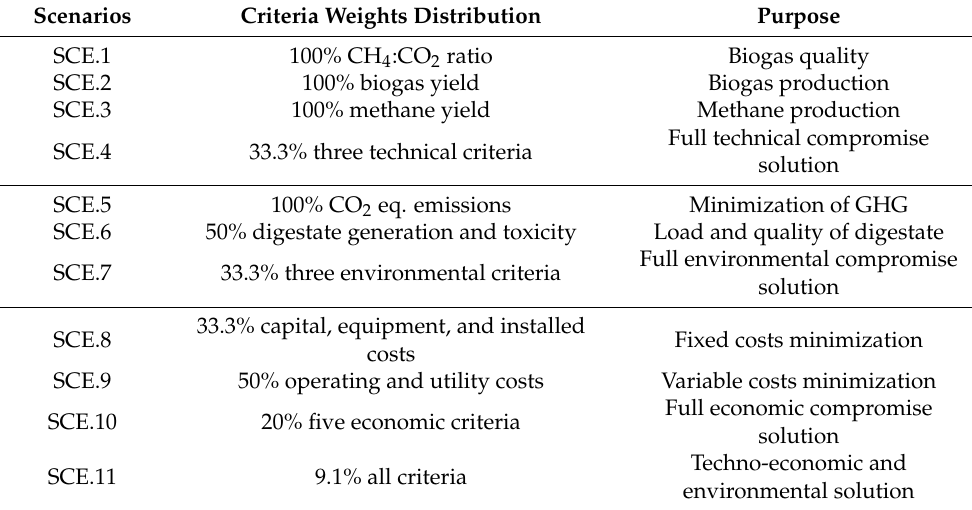
Table 2. Proposed scenarios evaluated through